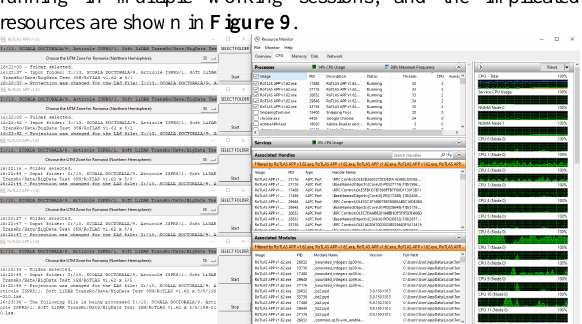
Figure 9 . Running multiple sessions of RoTLAS APP v1.62